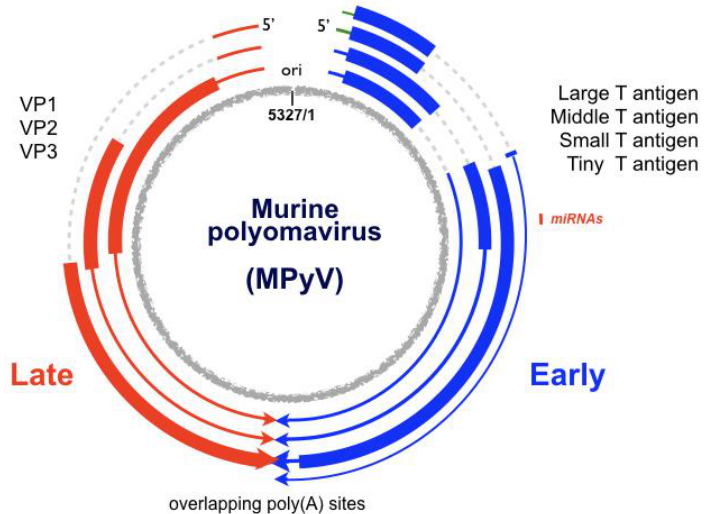
Figure 1. The murine polyomavirus (MPyV) genome. The genome shown is of strain NG59RA, which is 5327 base pairs in length. Early genes are in blue and late genes are in red. Transcripts are lines, with thicker regions denoting open reading frames and dotted lines introns. The replication origin and transcriptional control region is shown at the top of the genome. Late-strand transcripts can give rise to two miRNAs (small red line) that map to the early region and can influence viral and host gene expression.